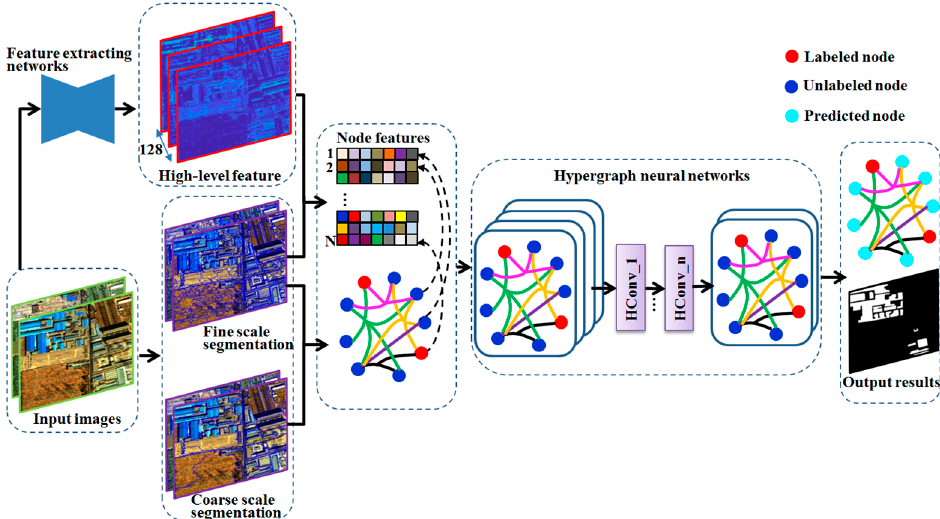
Figure 2. Flowchart of the proposed method.